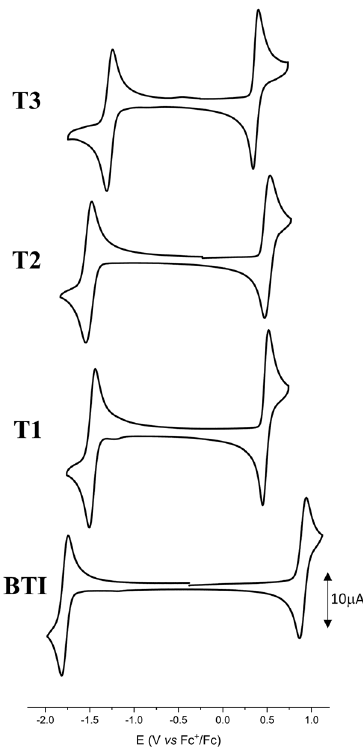
Fig. 3 Cyclic voltammetry. Cyclic voltammograms of thionated compounds ( T1 – T3 ) recorded at 100 mV s − 1 in 0.10 M Bu 4 NPF 6 /CH 2 Cl 2 and comparison with that of the reference BTI